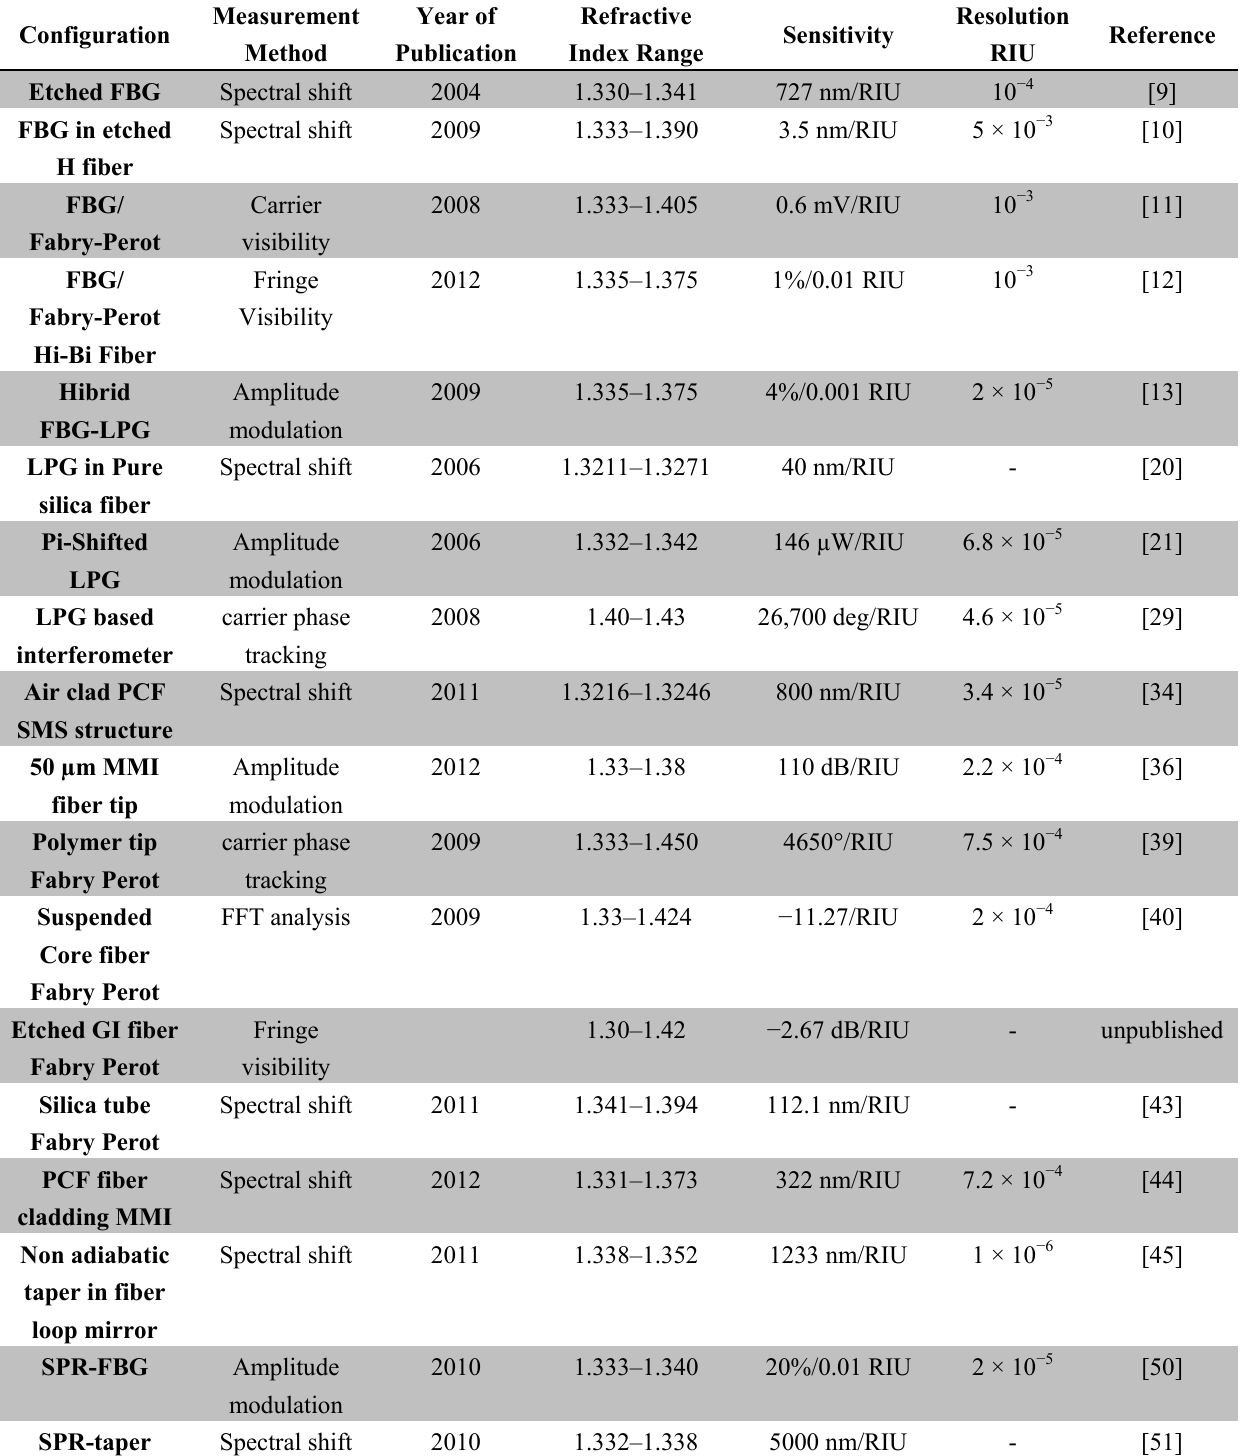
Table 1. Summary of most relevant optical fiber based refractometers developed at INESC